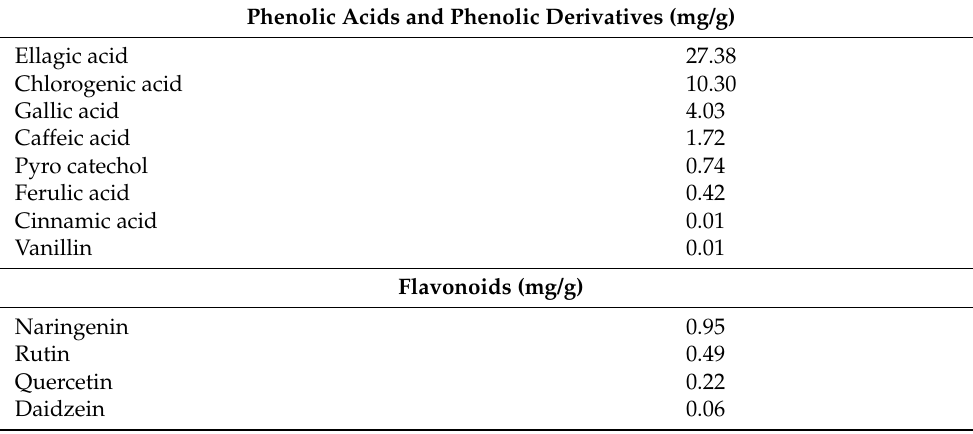
Table 3. Phenolic profile of pomegranate-guava-grape leaves (PGG)